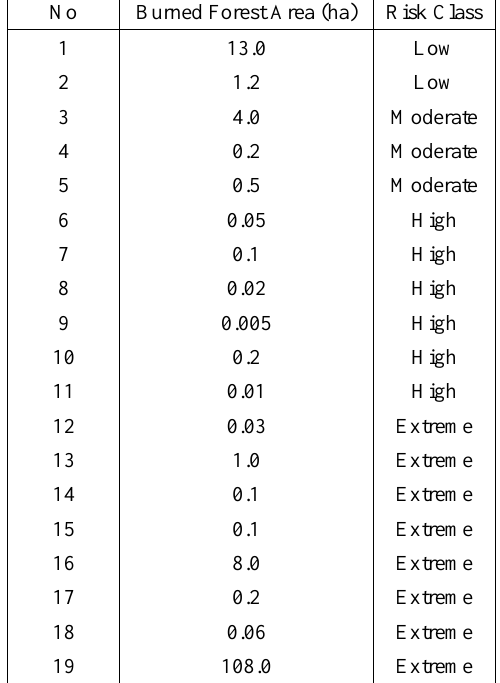
Table 3 . The fire risk class of the previous fires.